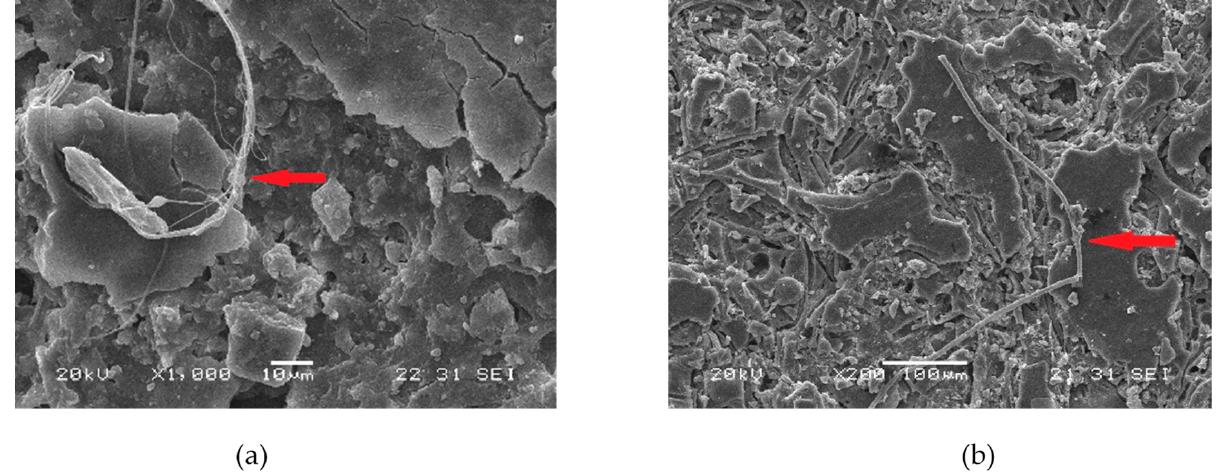
Figure 3. Micrographs of HBC2 ( a ) and HBC4 ( b ) surfaces composted for 150 days. The red arrow shows the presence of a microbial hypha formed during composting.